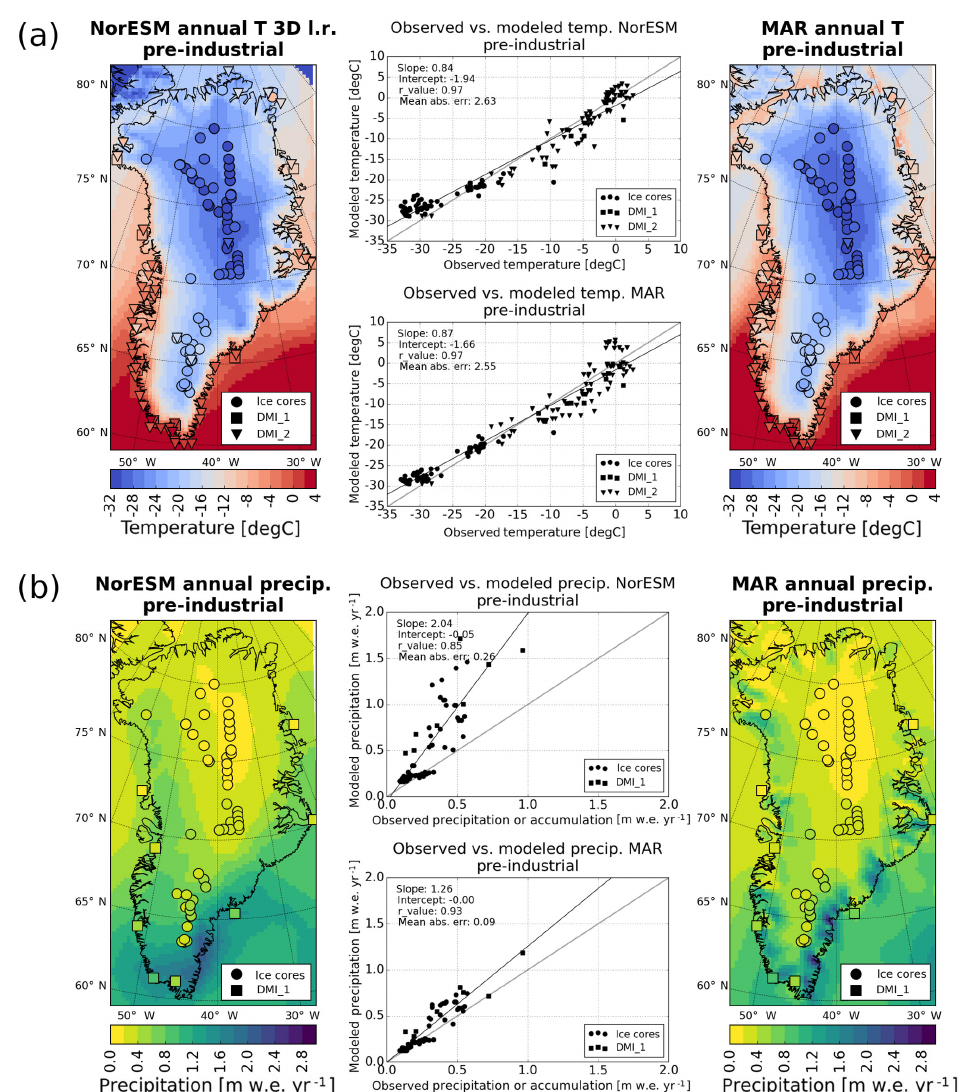
Figure 5. Annual mean near-surface air temperature and precipitation simulated with NorESM and MAR for pre-industrial conditions. The NorESM temperature is corrected with the temporally and spatially varying 3-D lapse rate (see Sect. 4.2). Row (a) shows modeled temperatures with observations from ice cores and weather stations plotted on top. Additionally, scatter plots of observed vs. modeled temperature for each model are presented. The bold gray lines represent the 1 : 1 diagonal and hence a perfect fit between model and observations. Row (b) shows the same for annual mean